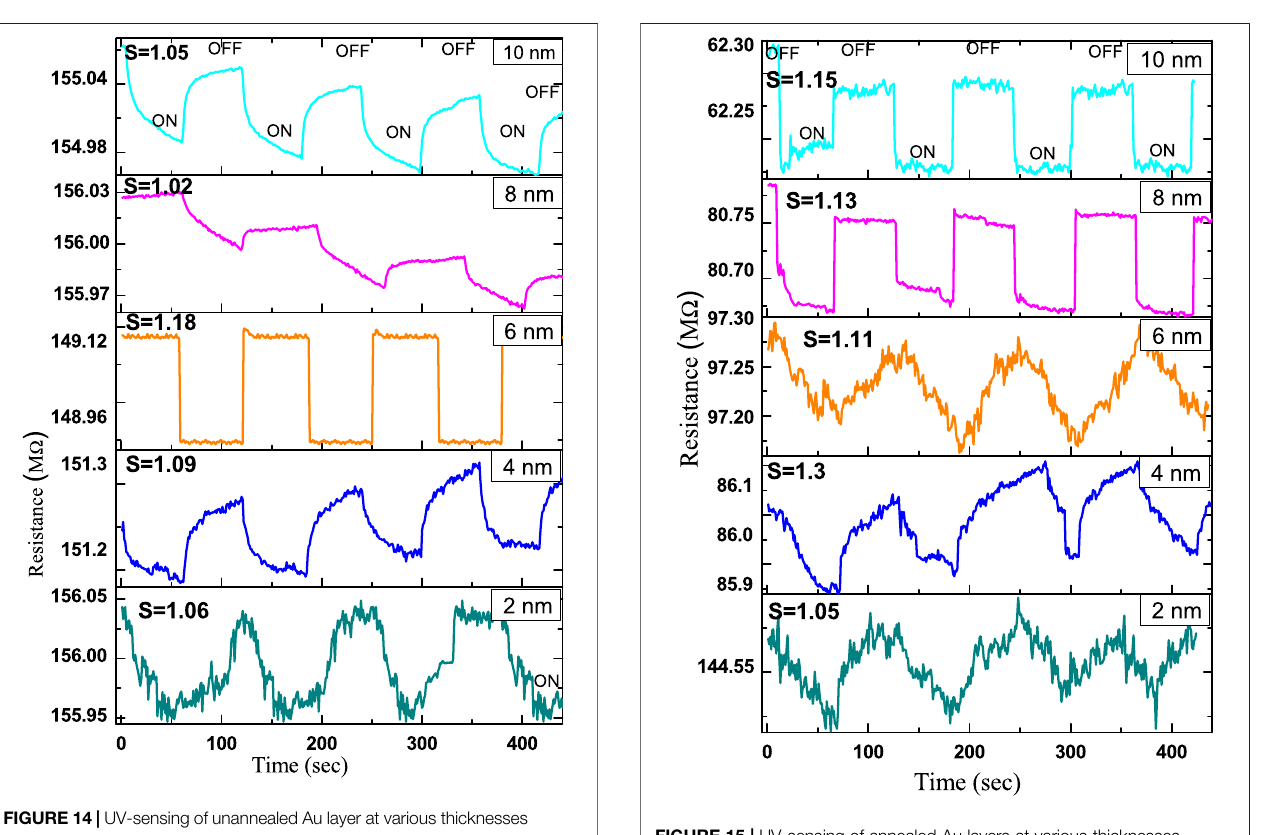
with a cycle of 1